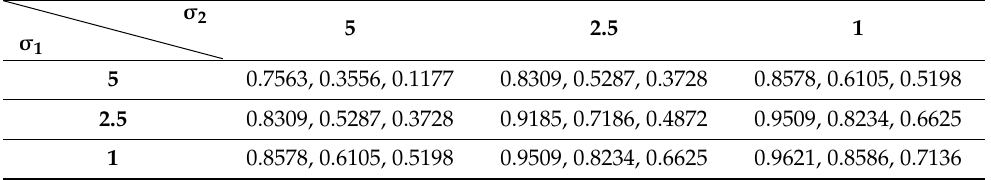
Table 3. Values for GBC 1 , GBC 2 , and GBC 3 for a binormal distribution with means µ 1 = 33, µ 2 = 66 and variances σ 2 , σ 2 2 1